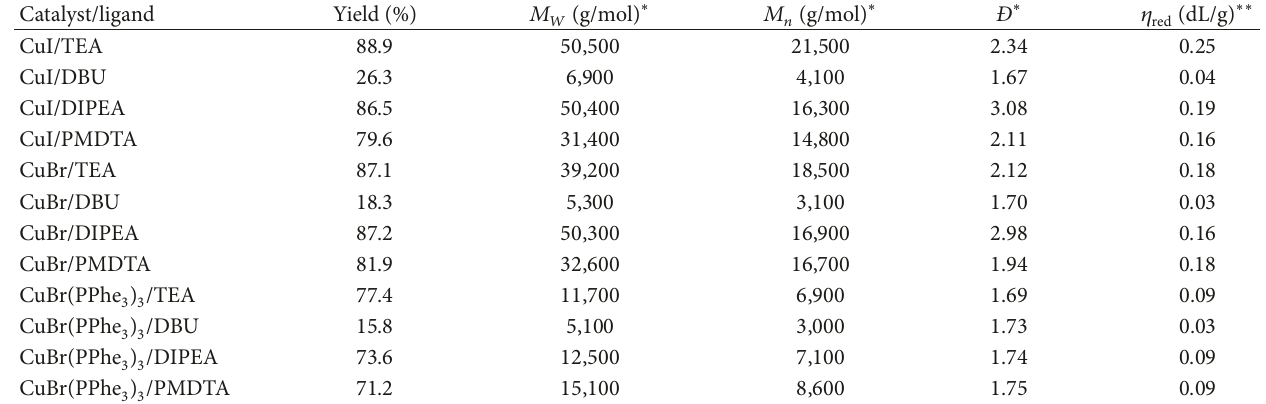
Table 7: The influence of the catalyst and ligand’s nature on the characteristics of PE8E4.